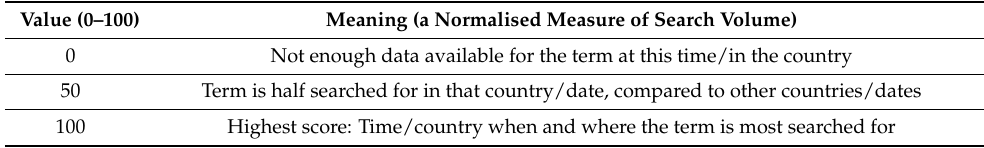
Table 2. Metrics and values used in Google Trends.